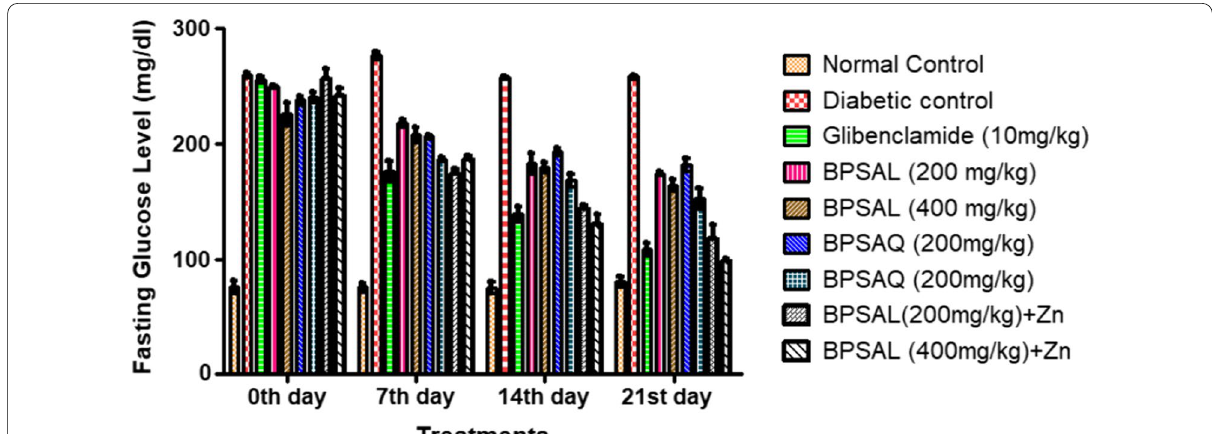
S.E.M ( n 6); ** P < 0.001 ± = =